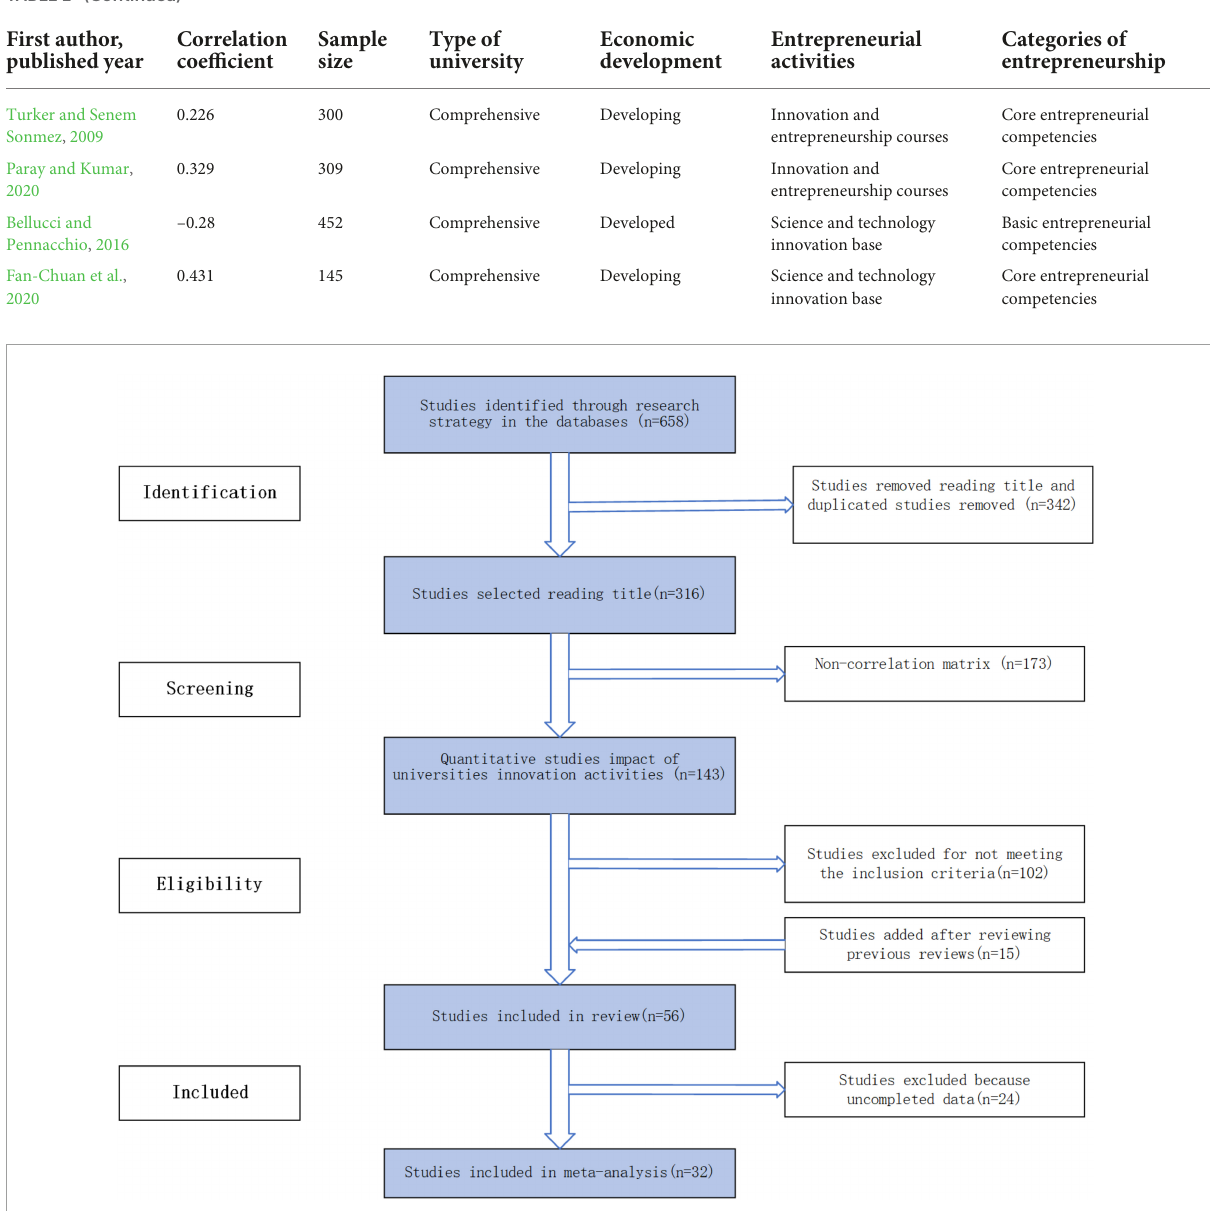
FIGURE2 Stages in the process for selecting studies for the meta-analysis.